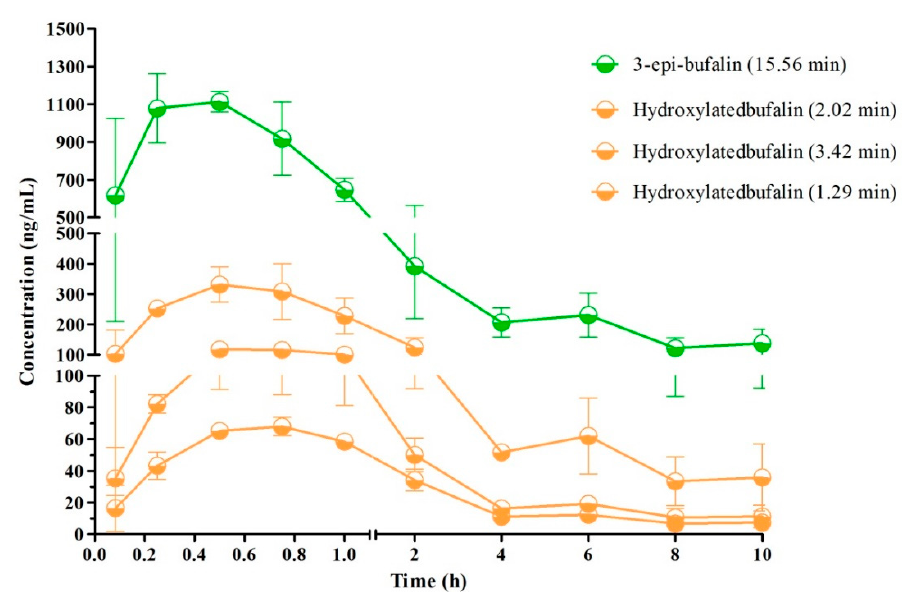
Figure 7. Mean plasma concentration–time profiles of metabolites ( C max was above 50 ng/mL) in rats after oral administration of 10 mg/kg ( n = 3).